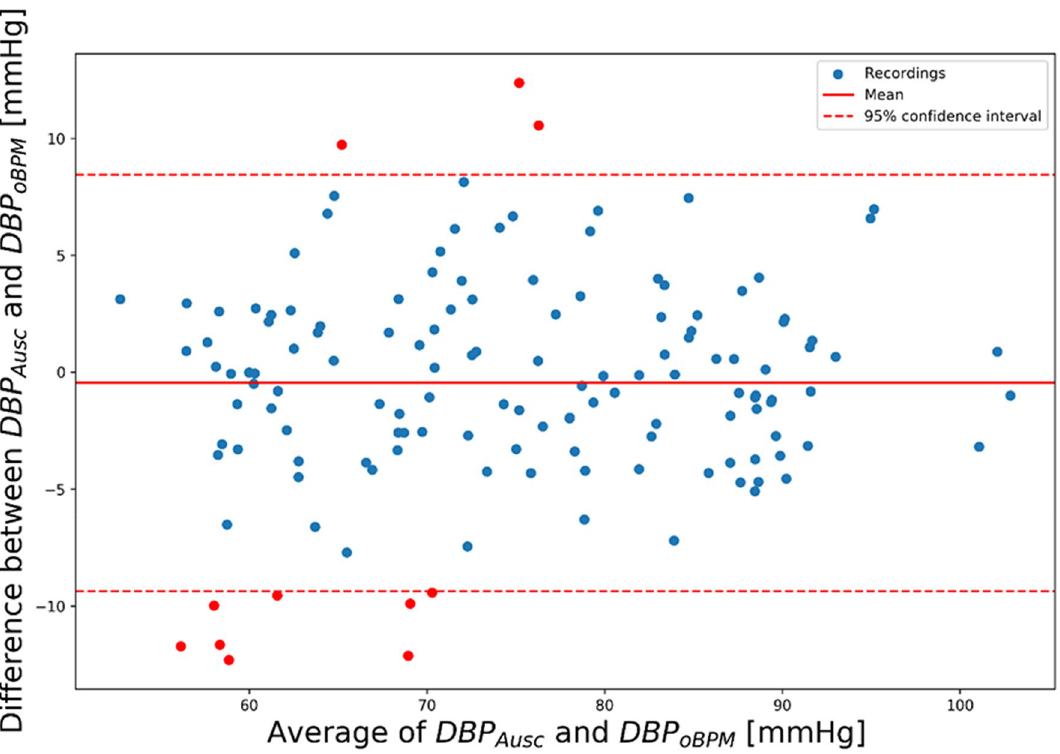
Figure 5. Standardized Bland–Altman scatterplots depicting the agreement between the OptiBP smartphone app diastolic estimates assessed by the oBPM algorithm (DBP oBPM ) and the auscultatory-derived reference systolic BP measurements (DBP Ausc